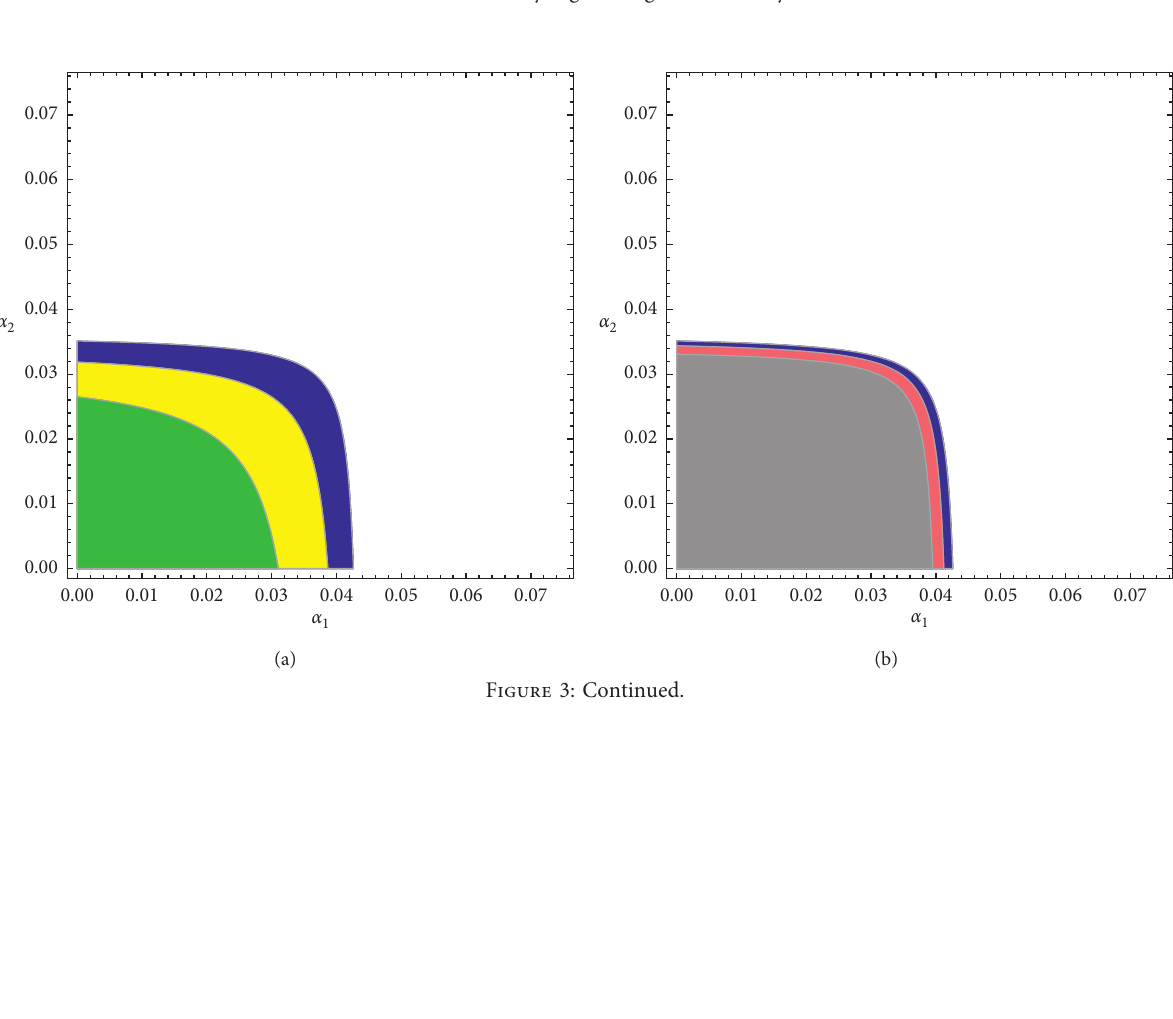
Figure 2: The stability region diagrams of the